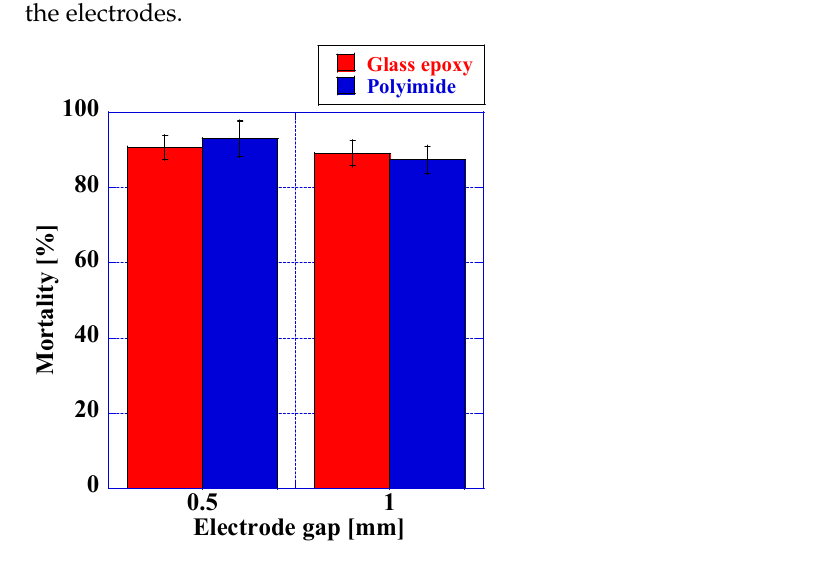
Figure 4. Variation in mortality as a function of substrate insulator. No significant differences in mite control efficacy were observed as a result of variations in the insulating material of the electrodes or the polarity of the discharge voltage. The electrodes were made of glass epoxy or polyimide with a distance between electrodes of 0.5 mm and 1.0 mm and a frequency of 100 Hz. The error bars in the data show the standard deviation.